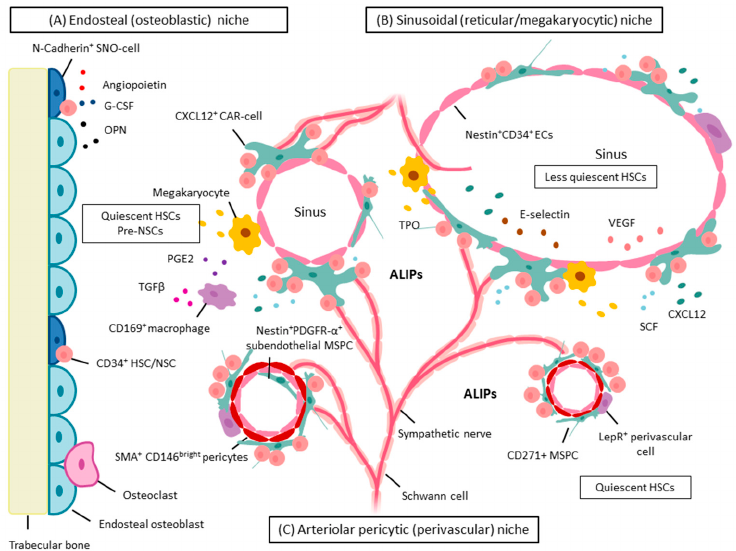
Figure 2. Current stem cell (SC) niche concepts. ( A ) Endosteal (osteoblastic) niche. Hematopoietic stem cell (HSCs) adhere to spindle-shaped N-cadherin + osteoblastic cells. The endosteal niche is thought to promote HSC quiescence. Osteolineage cells provide a specialized niche for early lymphoid progenitors (not shown); ( B ) Sinusoidal (reticular/megakaryocytic) niche. The majority of HSCs are associated with sinusoidal endothelium and/or megakaryocytes, which in turn are intimately associated with sinusoidal endothelium. Leptin-receptor + cells and CXCL12 abundant reticular (CAR) cells are predominantly located in sinusoidal niches and are in close contact with endothelial cells (ECs); ( C ) Arteriolar (perivascular) niche. CD146 + pericytes and Leptin-receptor + perivascular stromal cells are the predominant mesenchymal stem and progenitor cell (MSPC) components of the arteriolar niche. Sympathetic nerves are part of the bone marrow (BM) SC niches and are critically involved in the circadian regulation of (i) the secretion of CXCL12 by MSPCs; (ii) HSC adhesion to the SC niche; as well as (iii) osteogenic differentiation. Adrenergic signals and BM neuropathy may also promote leukemic infiltration and disease progression.